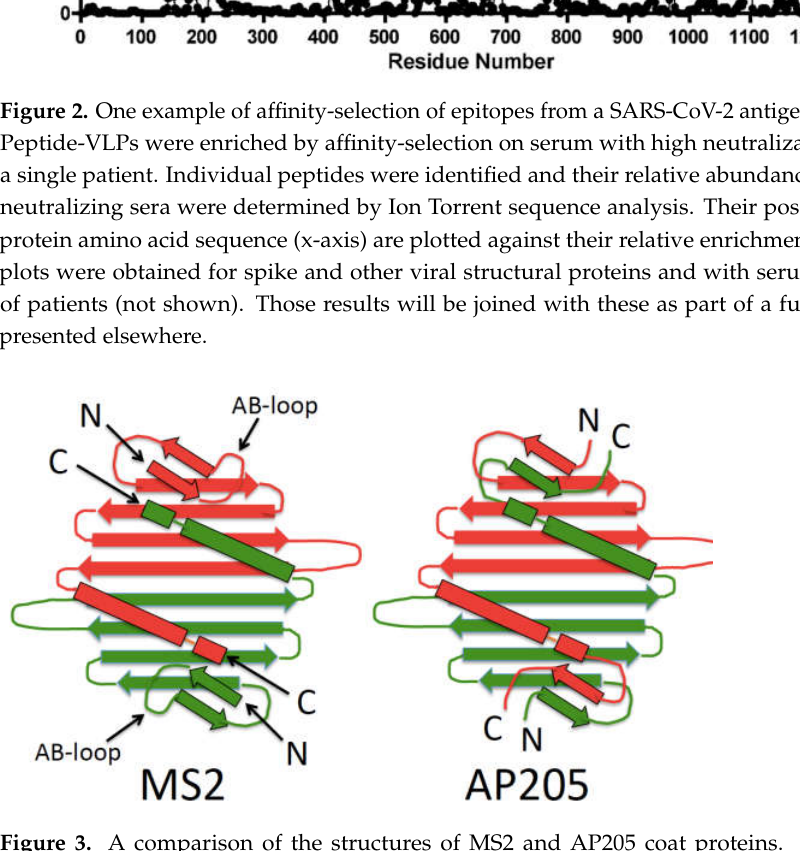
Figure 3. A comparison of the structures of MS2 and AP205 coat proteins. Despite extensive diver- gence of amino acid sequence, their three-dimensional structures are largely conserved. Note how- ever, that the structural homolog of the N-terminal-most ß-strand of MS2 is moved to the C-termi- nus in AP205, causing the two sequences to be related by circular